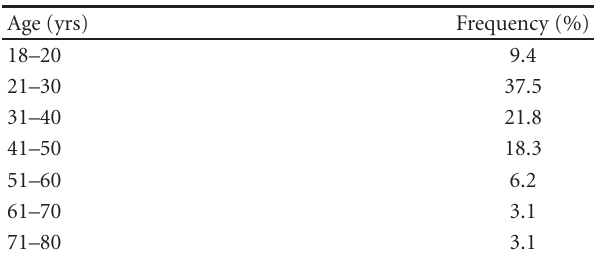
Table 3: Distribution of ASD according to age of